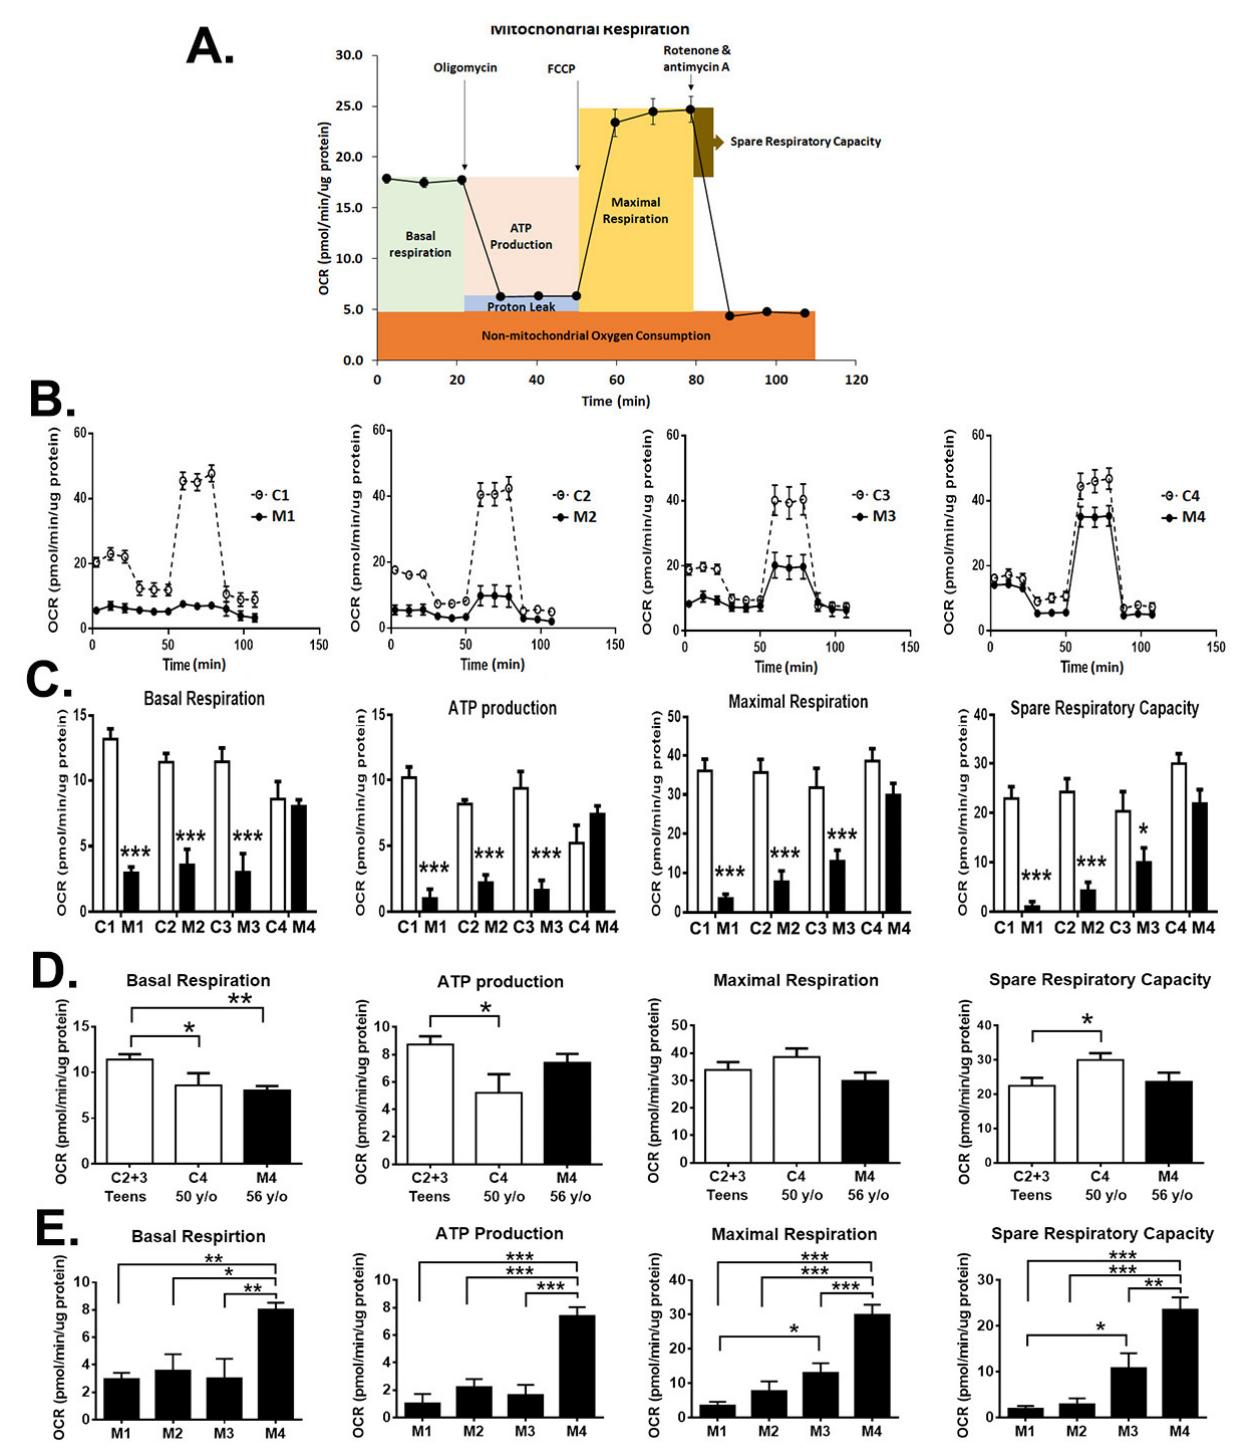
Figure 6. Bioenergetics profiles of MELAS iNs. ( A ) General scheme depicting oxygen consumption rate (OCR) following sequential addition of oligomycin (ATP synthase inhibitor), FCCP (uncoupler), and Rotenone + Antimycin A (electron transport chain inhibitors) in cells to derive parameters of mi- tochondrial respiration. ( B ) Representative profile of bioenergetic analysis in control (C1, C2, C3,